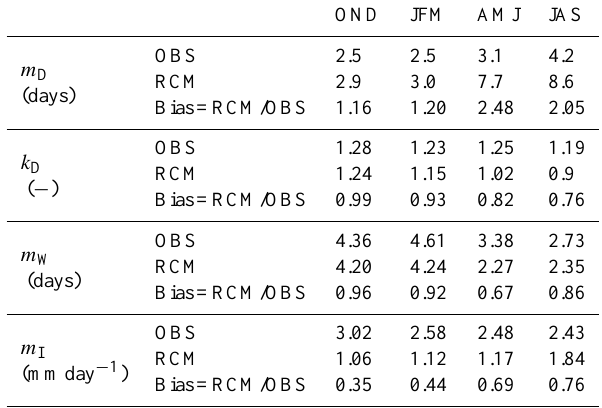
Table 1. Analysis of RCM predictive performance through the as- sessment of the model/observation bias (RCM/OBS) of the follow- ing storm parameters relative to cell #4: mean storm intensity ( m I ) , mean wet period ( m W ) , mean dry period ( m D ) and Weibull shape parameter ( k D ) . The parameters are estimated seasonally for the reference period 1961–1990. Each season of the year is reported according to the initials of the corresponding months.